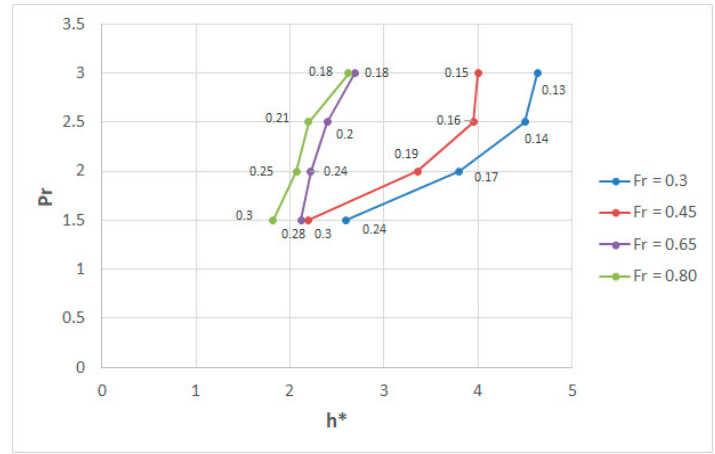
Figure 28. Contour lines of the threshold of failure for Scenario 5 end caps attached to the deck.